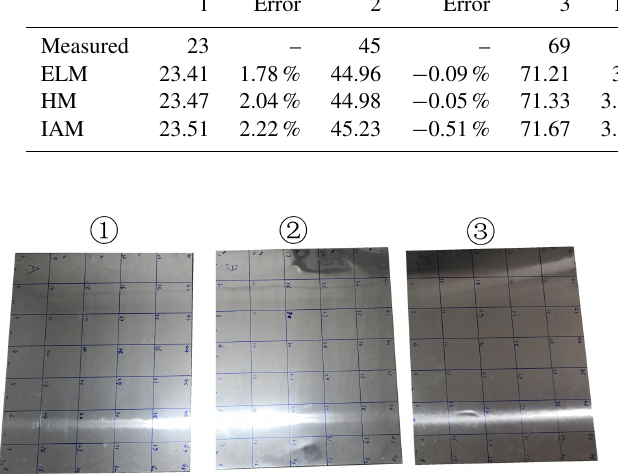
Figure 9. Aluminum honeycomb sandwich panel.